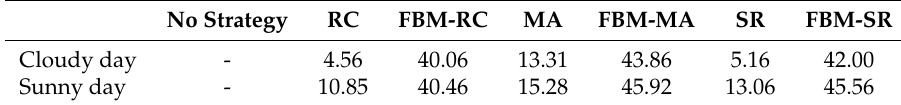
Table 7. Values of ∆ SoC for each strategy in both